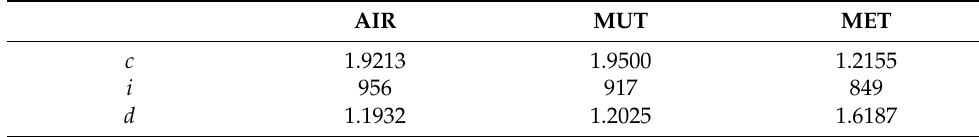
Table 1. Optimized parameters for the three configurations.